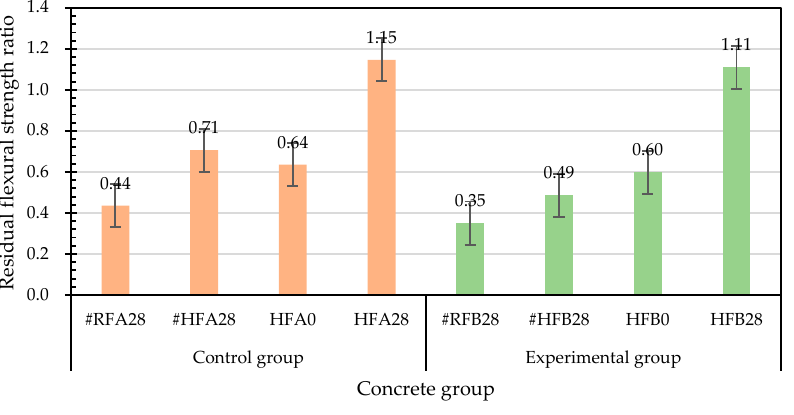
Figure 23. Effects of different test parameters on the relative-flexural-strength ratios of concrete.